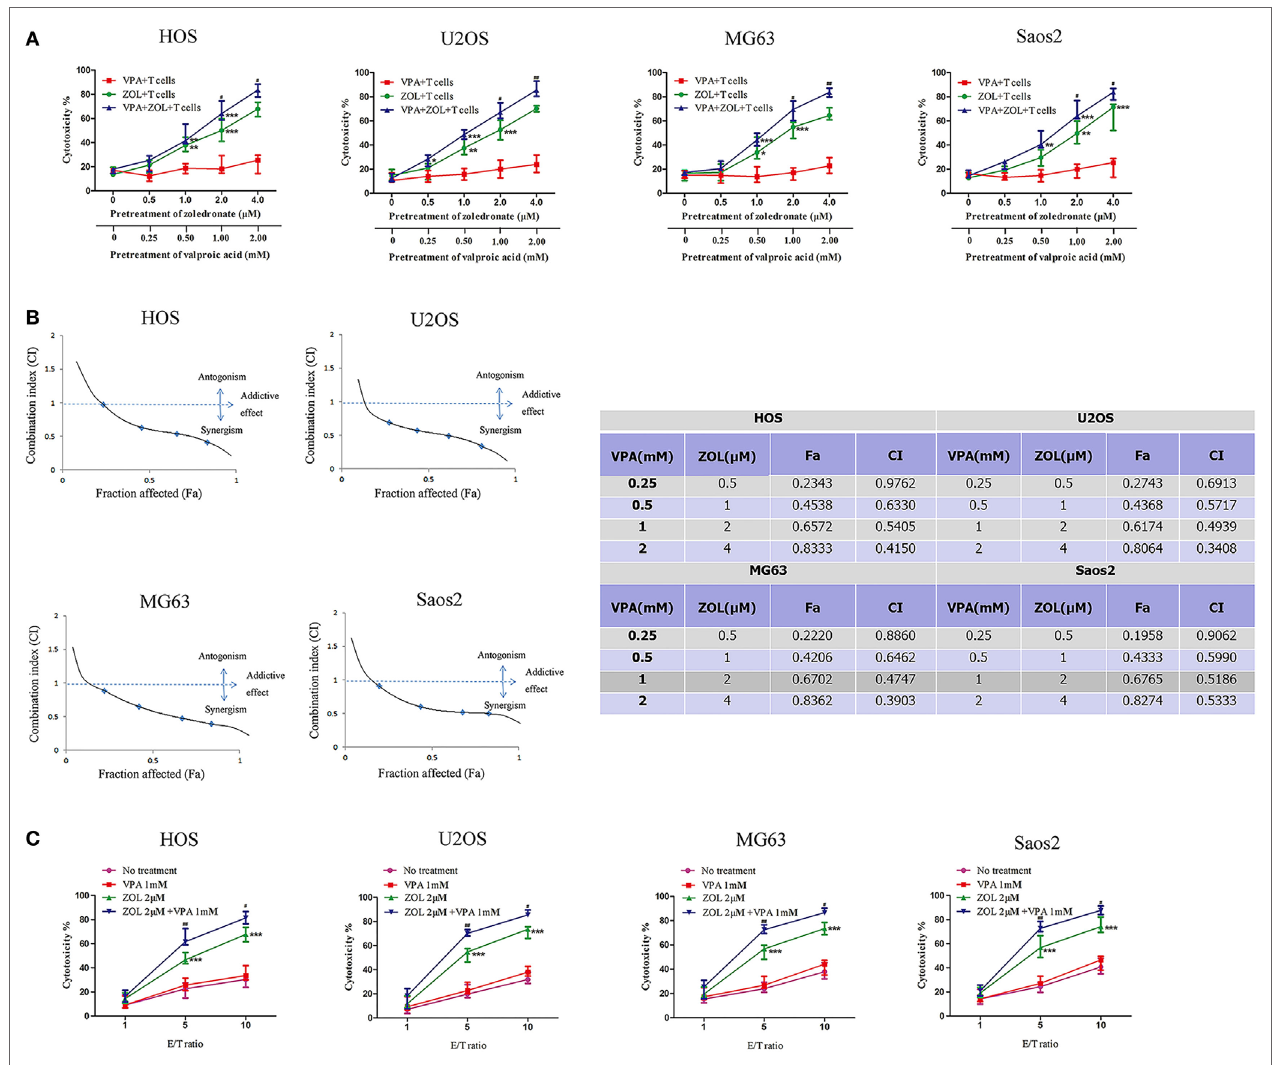
FigUre 1 | Valproic acid (VPA) and zoledronate (ZOL) synergistically induce γδ T cells cytotoxicity against osteosarcoma cells. (a) HOS, U2OS, MG63, and Saos2 cells were treated with different concentrations of VPA and ZOL at a certain ratio. After 24 h, tumor cells were co-cultured with γδ T cells at an E:T ratio of 5:1 for 2 h. Then the antitumor effect was measured by MTS assay. (B) The fraction affected (Fa) and combination index (CI) were calculated by Calcusyn. The synergistic effect of VPA and ZOL was determined by CI plot. (c) Tumor cells were pre-treated with control, 1 mM VPA, 2 µM ZOL, and VPA + ZOL, respectively, for 24 h. Then they were co-cultured with γδ T cells at the indicated E:T ratios for 2 h. The antitumor effect was measured by MTS assay. Each performed in triplicate. All the values were shown as mean ± SD; * p < 0.05, ** p < 0.01, *** p < 0.001 versus no pre-treatment, # p < 0.05, ## p < 0.01 versus pre-treatment with